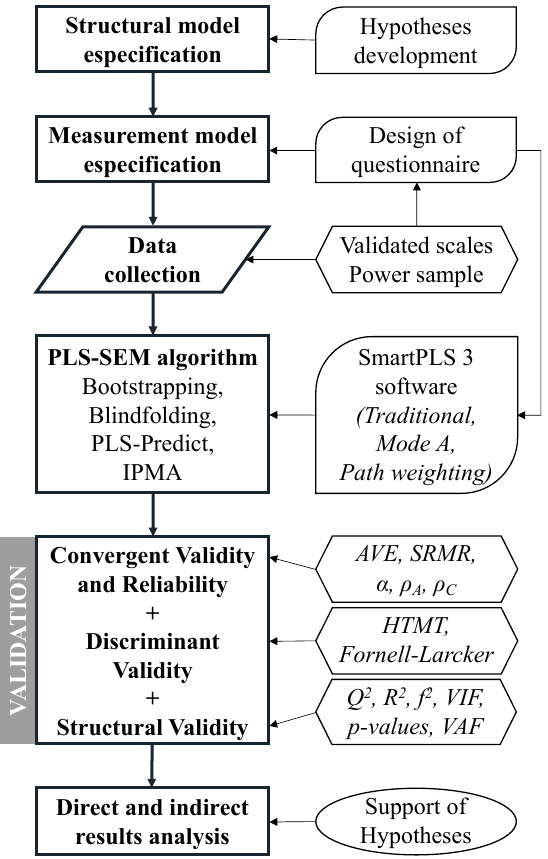
Figure 2 represents the workflow process to validate the hypotheses.